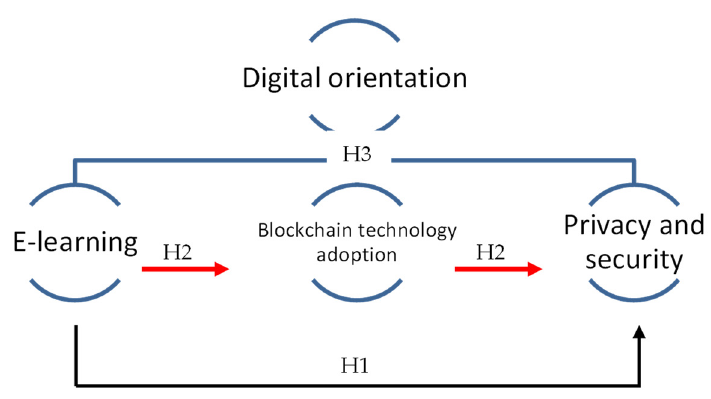
Figure 1. Theoretical framework. Source: Authors’ concept.